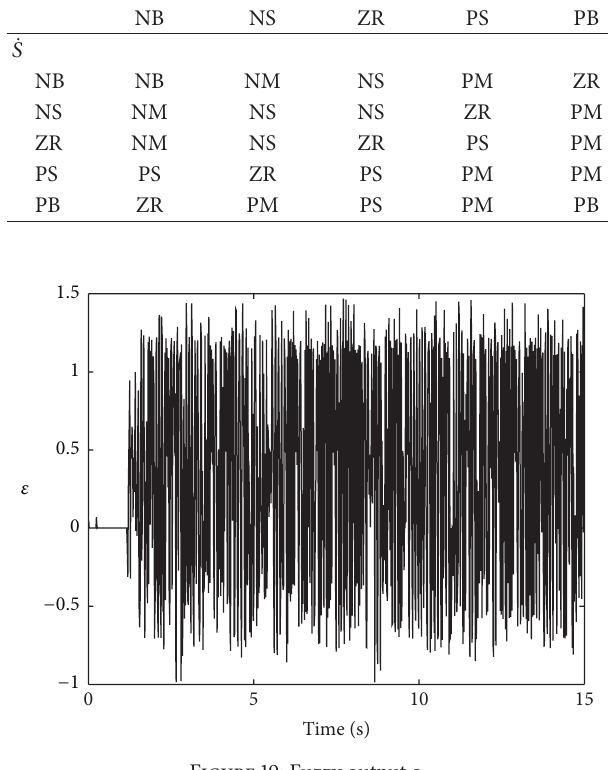
Figure 19: Fuzzy output 𝜀